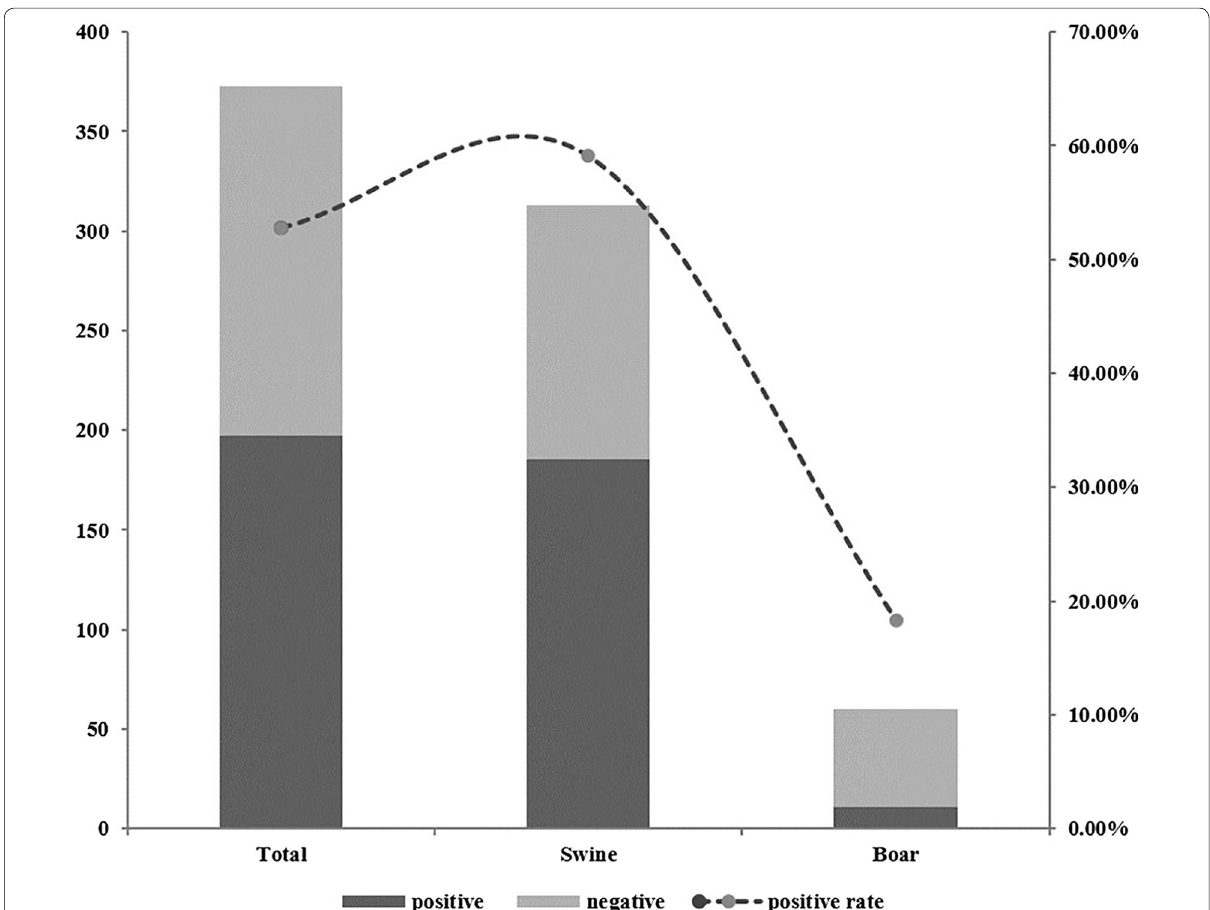
Fig. 6 A VLP ELISA was used to determine PCV3 positive rate of swine serum samples (n wild